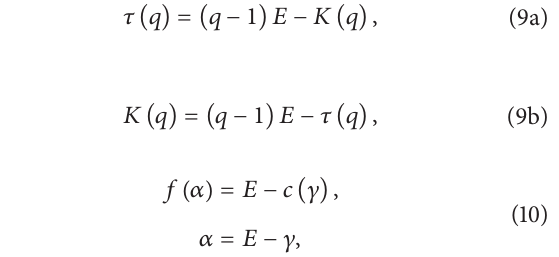
Figure 2: Box-counting dimension ( 𝐷 0 ) including points with an altitude less or equal to 𝑥 -axis value with the water reservoir empty. The blue arrow points out 𝐷 0 value when the reservoir is full.